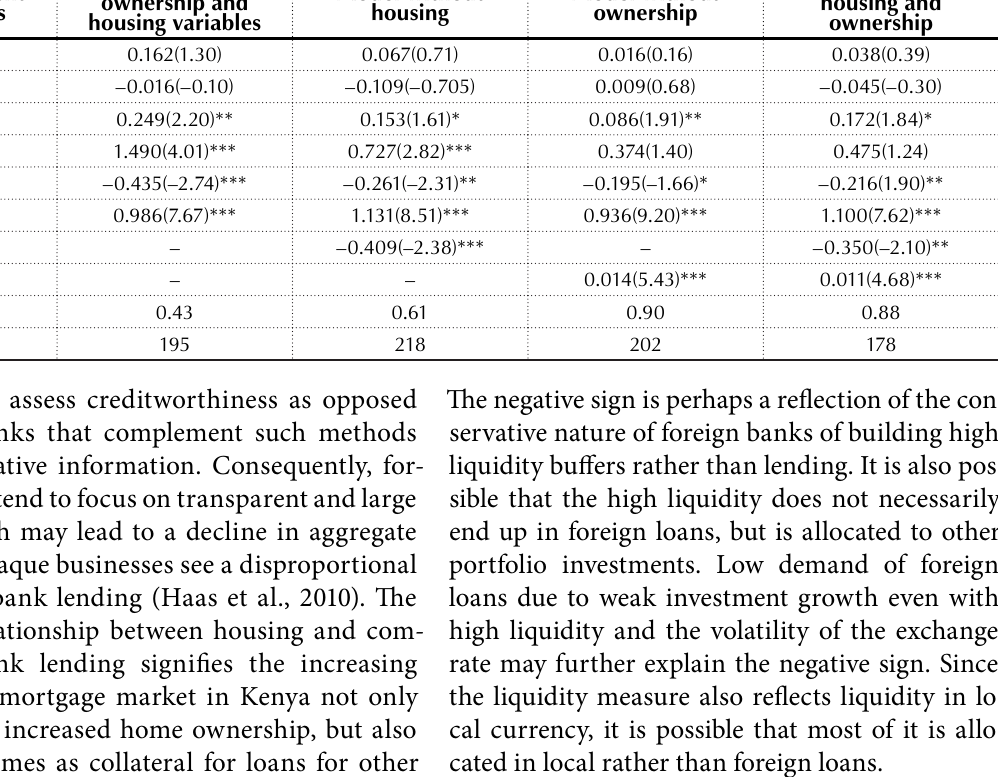
Table 1. The dependent variable is all loans of commercial banks Model without Independent ownership and variables